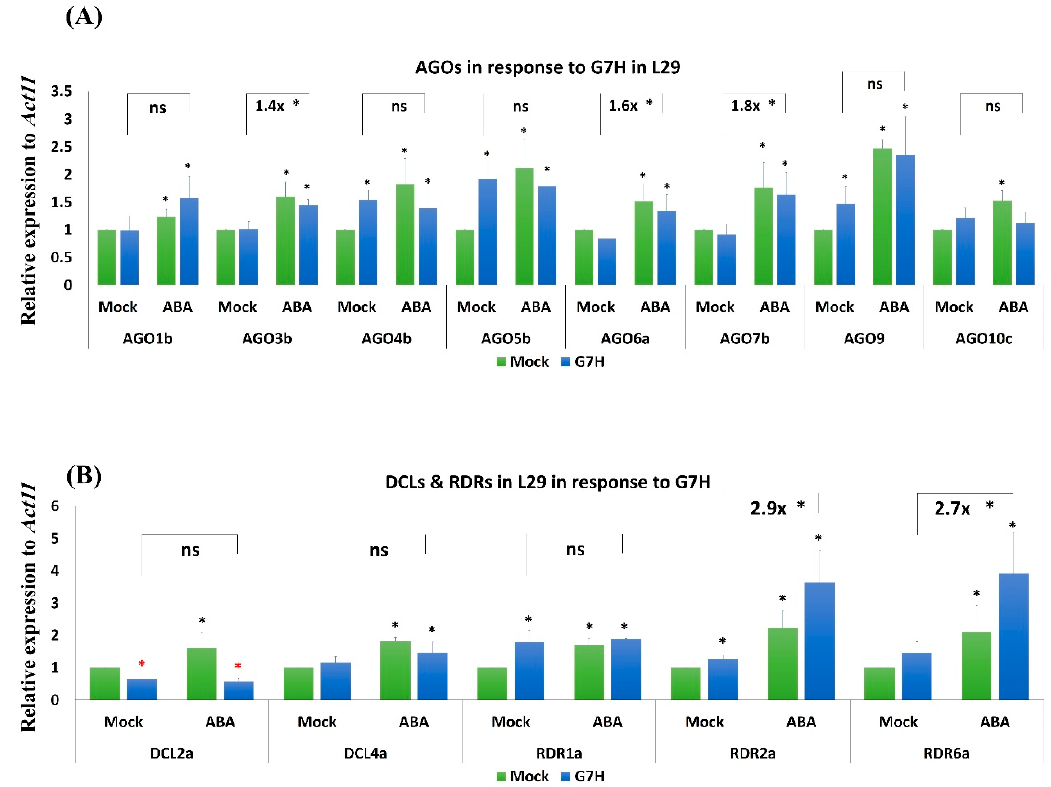
Figure 4. Expression levels of RNA-silencing genes in L29 plants infected with G7H. Expression levels of Argonaute ( AGO ) genes ( A ), and dicer like ( DCL ) and RNA polymerase ( RDR ) genes ( B ) in L29 plants in response to G7H infection, ABA treatment, or both. Plants were collected 5 dpi for RNA extraction and RT-qPCR. Values are means ± SD of three biological replicates. Statistical analysis was carried out for each gene using Student t -test; the means for plants treated with ABA alone, G7H alone, or the combination of ABA and G7H were individually compared with the mean for plants that were not treated with ABA or G7H: * and * indicate a significant increase or decrease, respectively, at P <